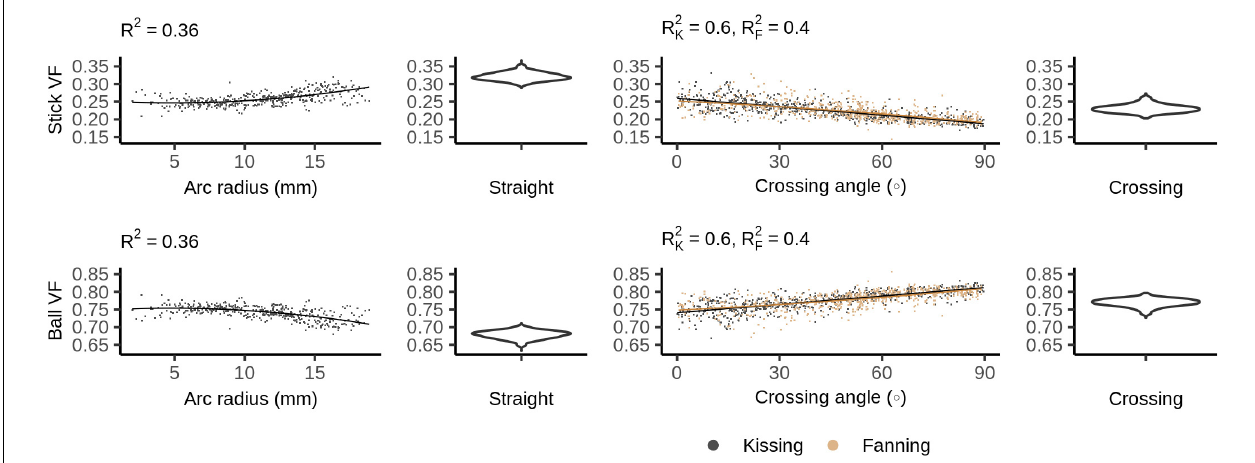
FIGURE 6 | Ball and stick volume fractions vs. orientation dispersion metrics in each of the four phantoms. The violin plots shown for the straight and crossing phantoms depict the probability density of values observed in the voxels of those phantoms.